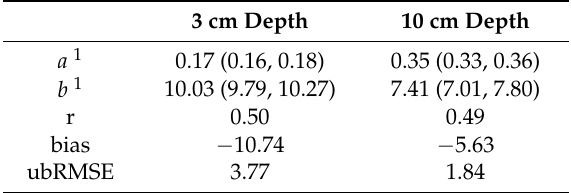
root-mean-square error (ubRMSE) between measured and modelled ε r are also